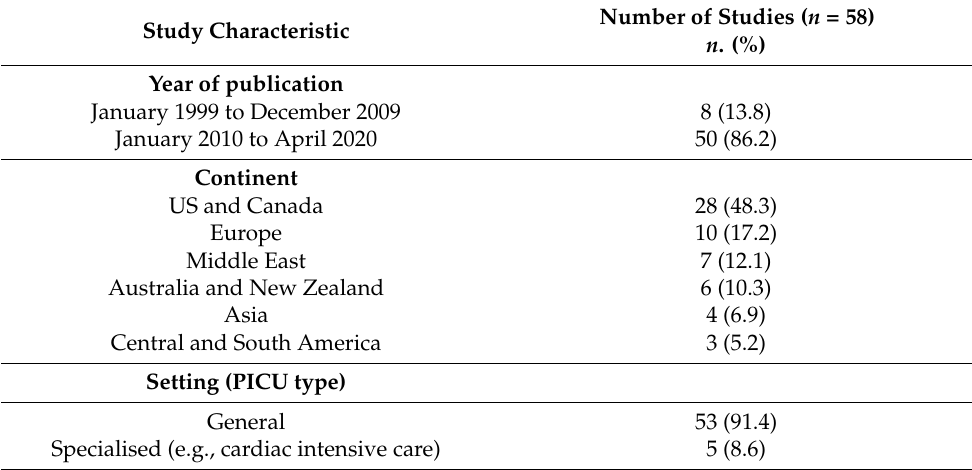
Table 3. Summary of the main study characteristics ( n =